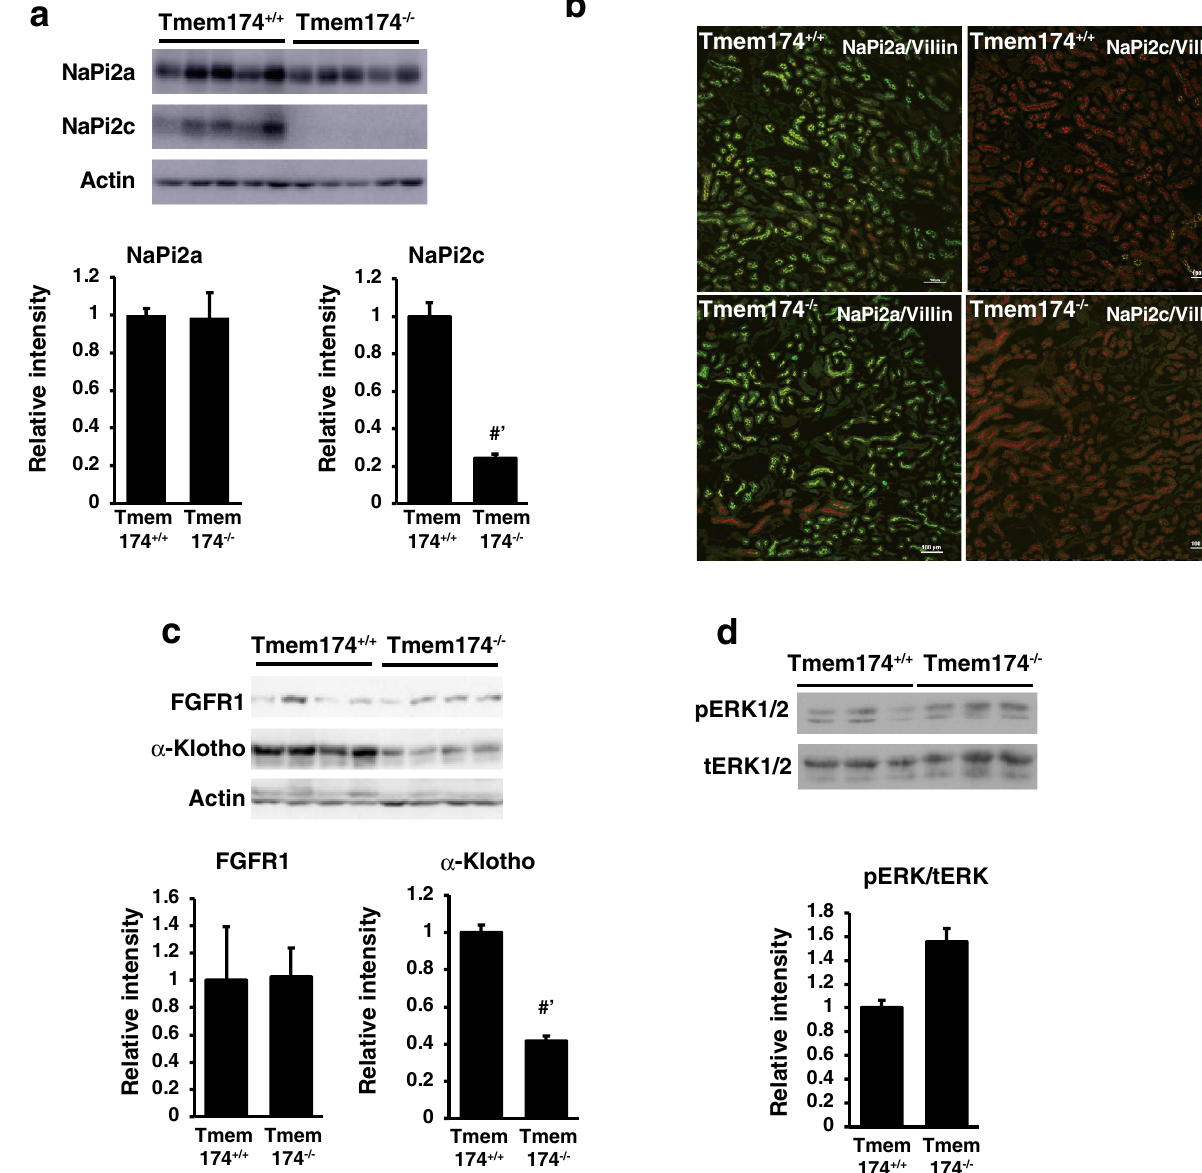
Figure 6. Deletion of Tmem174 and renal NaPi transporters. ( a ) Western blot analysis of NaPi transporters in Tmem174 +/+ and Tmem174 −/− mice (8-week-old mice, n = 5, respectively). Each lane was loaded with 20 μg of BBMVs. Actin was used as an internal control. Values are mean ± SE. #’ p < 0.01. Experiments were repeated at least 3 times. ( b ) Immunofluorescence staining of NaPi2a or NaPi2c (green) in renal sections of 8-week- old Tmem174 +/+ and Tmem174 −/− mice. DAPI (blue), Villin (red). Sections were prepared from kidneys embedded in the OCT compound and frozen. Scale bar; 100 μm. ( c , d ) Western blotting analysis of FGFR, α-Klotho ( c ), and total ERK1/2/phosphorylation ERK1/2 ( d ) levels. Each lane was loaded with 20 μg of cortical membranes ( c ) or whole homogenate ( d ). Actin was used as an internal control. Values are mean ± SE. #’ p < 0.01. Experiments were repeated at least 3